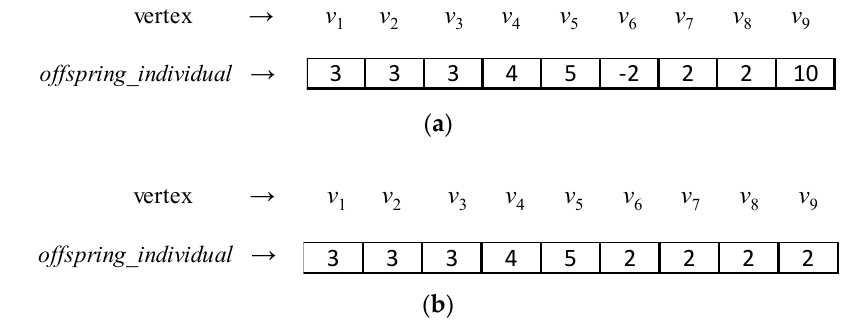
Figure 2. One of the offspring generated by mutation. ( a ) One of the offspring generated by mutation. ( b ) Adjusted community ID values.